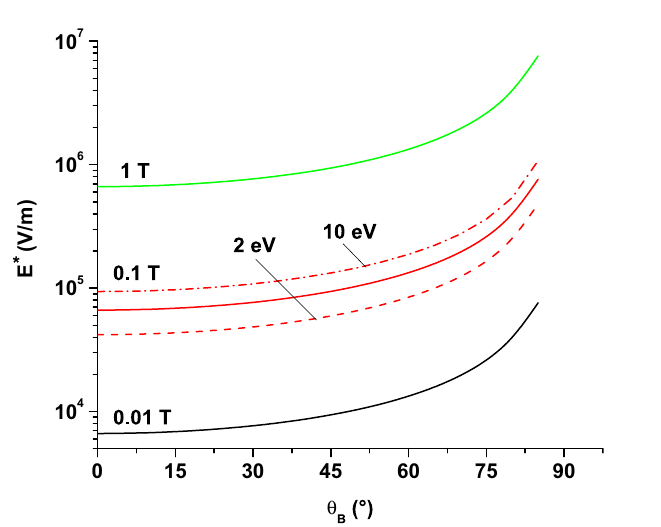
Figure 5. Different electric and magnetic fields combined in (11) to get specific values of the parameter A 5 eV except where clearly indicated). Typical magnetic field values for Hall thrusters (HT), hollow ( ǫ S = cathode discharges (HC), magnetron sputtering devices, linear plasma generators (LPG), and tokamaks are indicated.